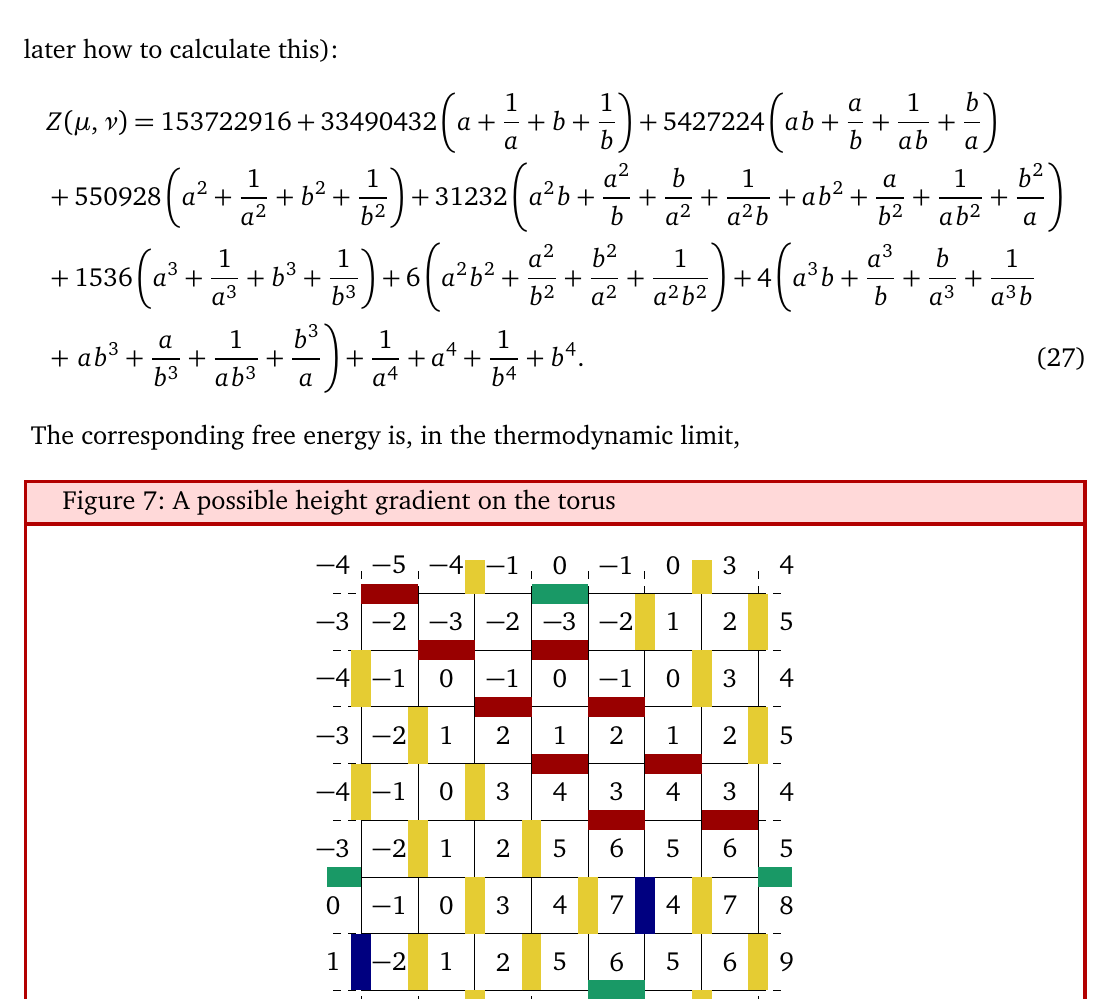
A dimer covering of the 8 × 8 torus, and its height configuration (in units of π/ 4). The fact that dimers can wrap around the torus means both r and s can be non zero. The slopes in this example are r = ( 8 / 8 ) π/ 4 = π/ 4, s = ( − 4 / 8 ) π/ 4 = − π/ 8. The dimer configuration drawn here contributes to the a 2 / b term in (27). Note that we refrain from identifying the bottom / top and leftmost / rightmost plaquettes here, for the sake of the